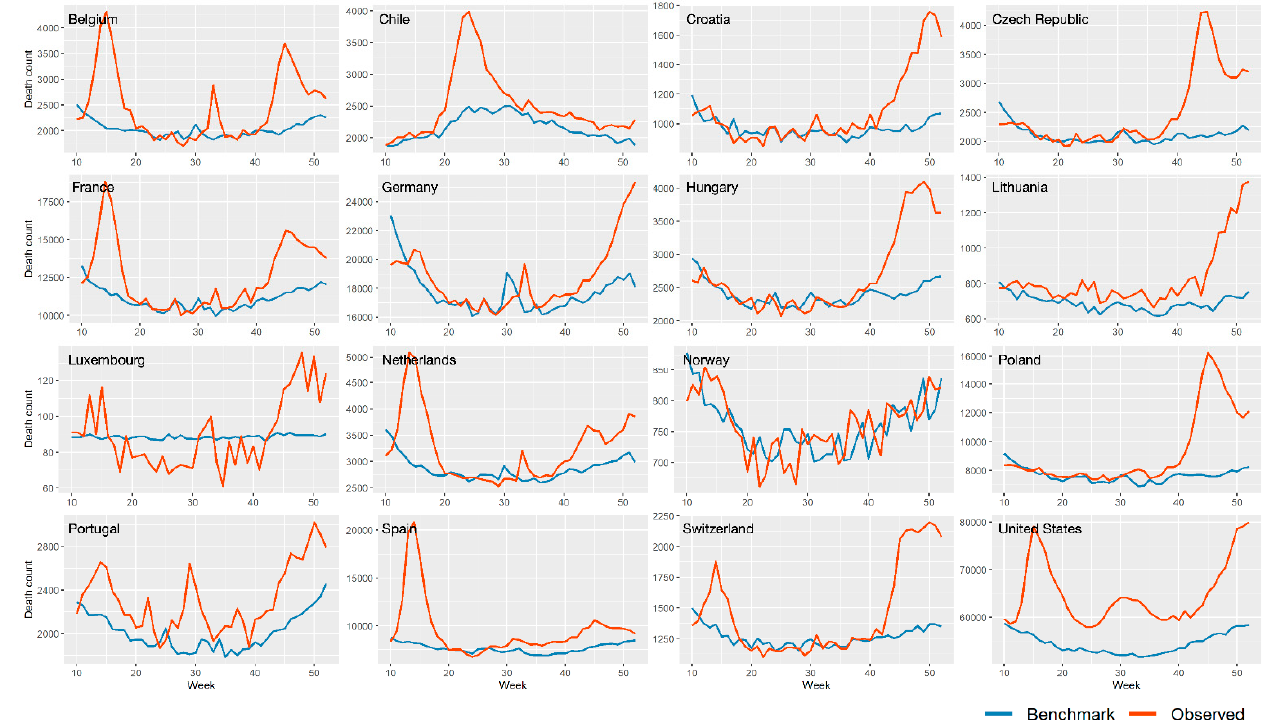
Figure 2. The all-cause observed and benchmark mortality during the 10th–52nd weeks in 2020 in 16 countries (The benchmark mortality is estimated by SARIMA model).